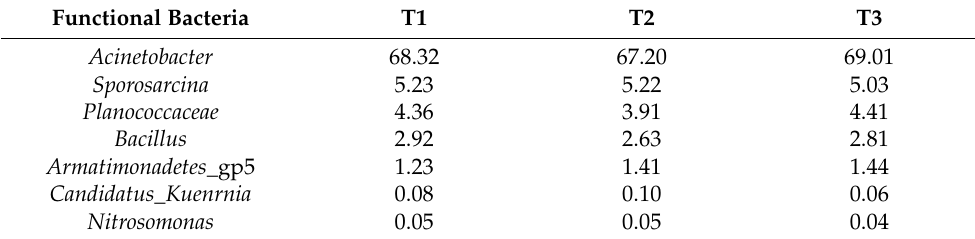
Table 4. Abundance of the main functional bacteria at the genus